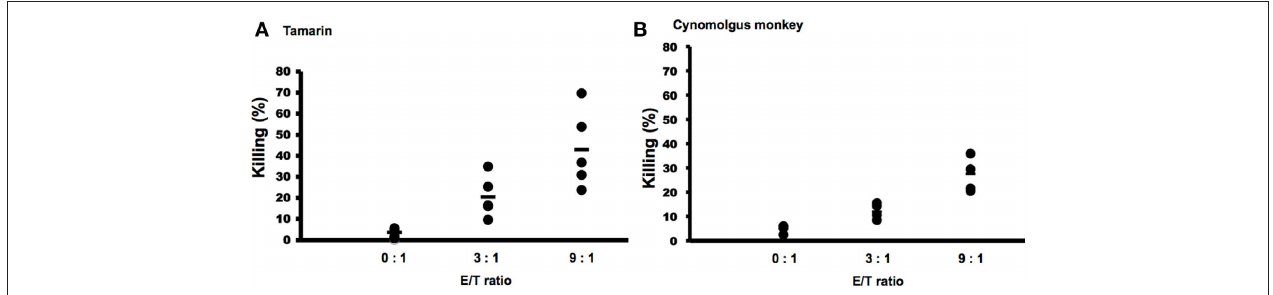
Figure 3 | Dose-dependency of killing activity of NK cells in tamarins. (A,B) K562 target cells were stained with CFSE and co-cultured with PBMCs as described in Section “Materials and Methods”. CFSE-stained K562 target cells were killed by PBMCs of tamarins and cynomolgus monkeys in a dose-dependent manner. For all experiments, the number of observations used to calculate the mean were n = 5. We analyzed statistically whether these killing activities were different between tamarins and cynomolgus monkeys by using StatView software.